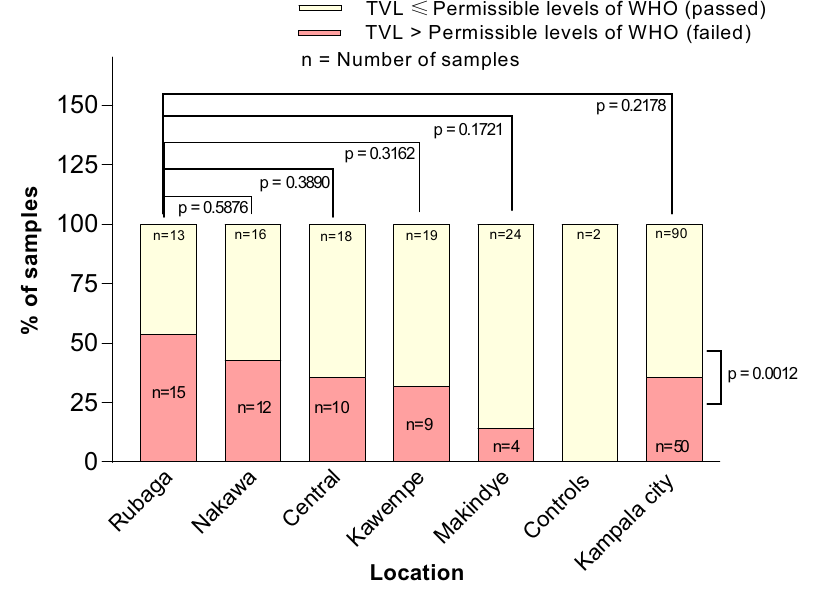
Figure 2. Conformity of the herbal medicines sold in Kampala to the permissible bacterial Total Viable Loads (TVL), that are recommended by World Health Organization (WHO) 18 . The p values show the significancy of differences in the proportions of samples that possessed unacceptable